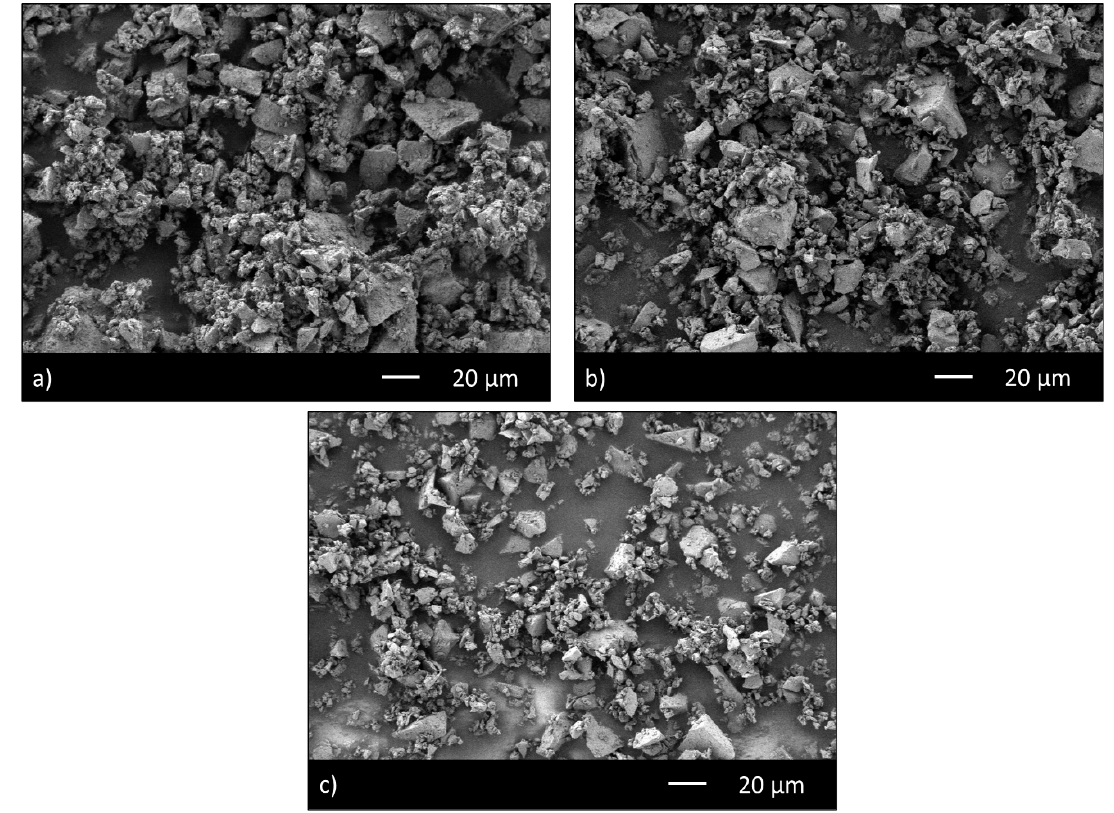
Figure 1. SEM analysis of bioactive glass particles after milling before electrospinning: 45S5 ( a ), BGMS10 ( b ), and BGMS_2Zn ( c ).